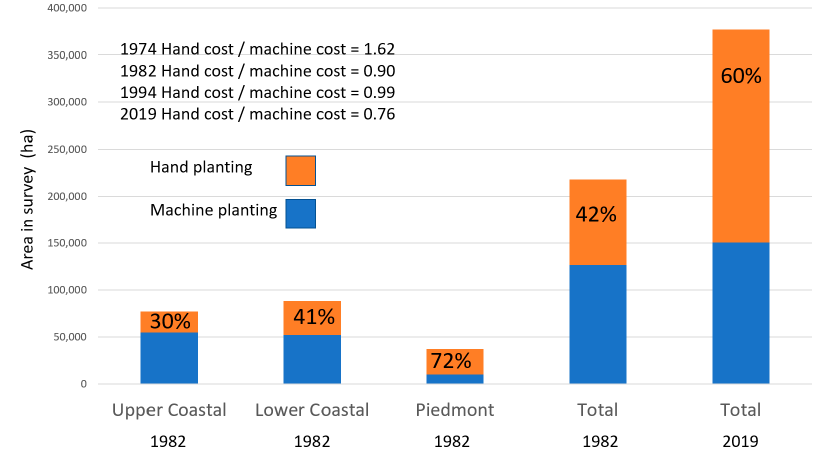
Figure 9. As the relative cost of machine planting increases, the proportion of hectares planted by hand increases. Data from [8,64].